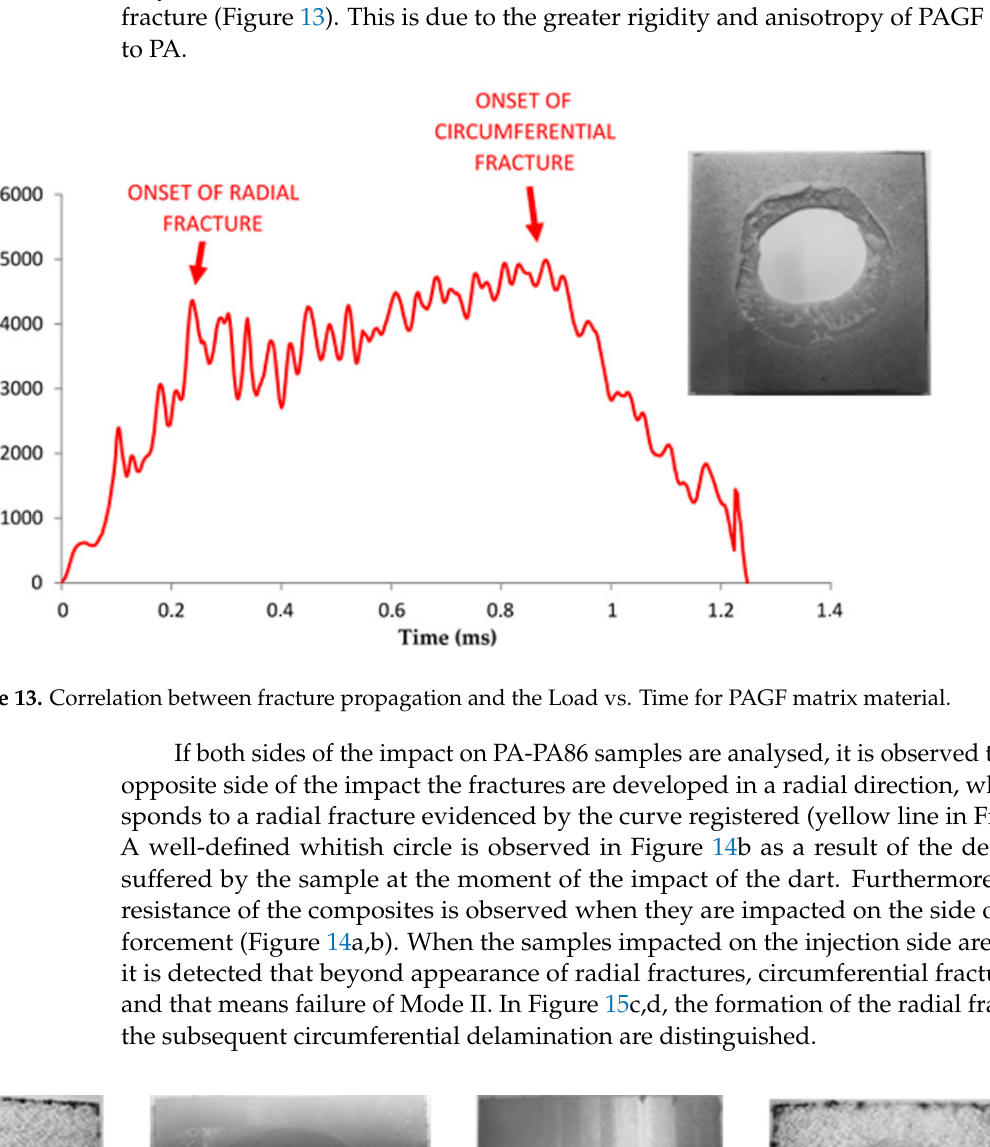
Figure 15. Impact samples on PAGF-PA86 composite. ( a ) Impact face on sample with ejector side impact. ( b ) Opposite impact face on sample with ejector side impact. ( c ) Impact face on sample with injection side impact. ( d ) Opposite impact face on sample with injection side impact. One of the reasons for the behaviour of the composites in the impact test could be the effect of delamination. However, because delamination reduces the bending stiffness and allows further deformation to occur, it also has a beneficial effect by limiting stresses that lead to fibre failure. If it were completely removed, there would be a risk of premature fibre failure, which could lead to a more brittle overall response [49,50]. 3.5. Three-Point Loading Test Regarding the monotonic three-point flexural test, the samples are not tested until breakage, thus only their behaviour in elastic mode was registered. The obtained values of the elastic modulus of PA and PAGF matrix are significantly higher than the ones ob- tained by Nagakura et al. [51], and these results may be due to the fact that PA used in this work is PA66, not PA6. In the Figure 16, it is verified that none of the composites show